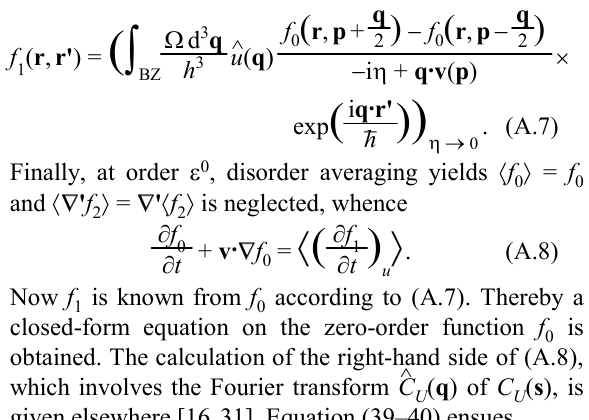
Table 4 . Light particle ( m << m ) governed by the Lorentz e integro-differential equation contrasted with heavy (Brownian) particle ( m >> m ) governed by the Klein-Kramers e